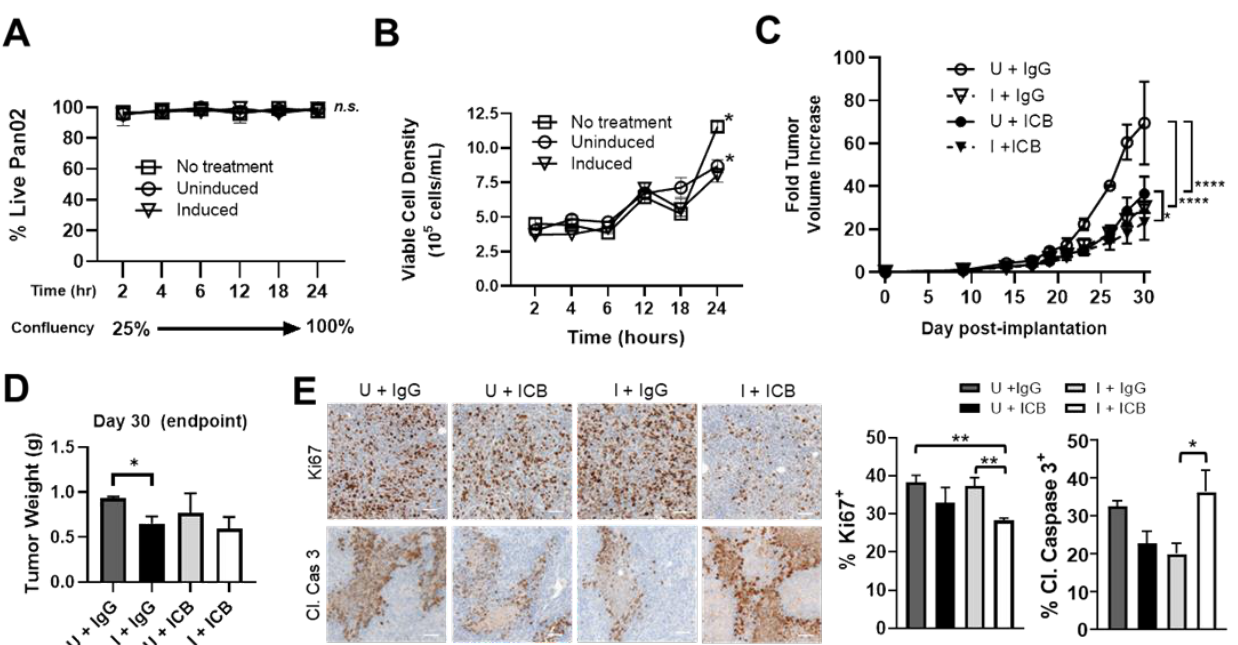
Figure 5. ST-SOT augments the anti-tumor effects of immune checkpoint blockade (ICB) treatment and is associated with a more permissive tumor immune microenvironment. ( A ) The direct effects of ST-SOT on tumor cell growth was determined through co-incubation with Pan02 cells at a confluency of 25% in antibiotic-free culture medium and using a starting multiplicity of infection = 50. Percent cell viability was determined by trypan blue staining at various time points in uninfected culture (no treatment) or post-infection under inducing (2% L-arabinose) or non-inducing conditions for 24 h. Kinetics of tumor cell growth (cells/mL) ( B ) were also performed simultaneously over the 24 h co-incubation period. * p < 0.05, two-way ANOVA. ( C ) C57BL/6 mice bearing s.c. Pan02 tumors (average 100 mm 3 , n = 3–5)